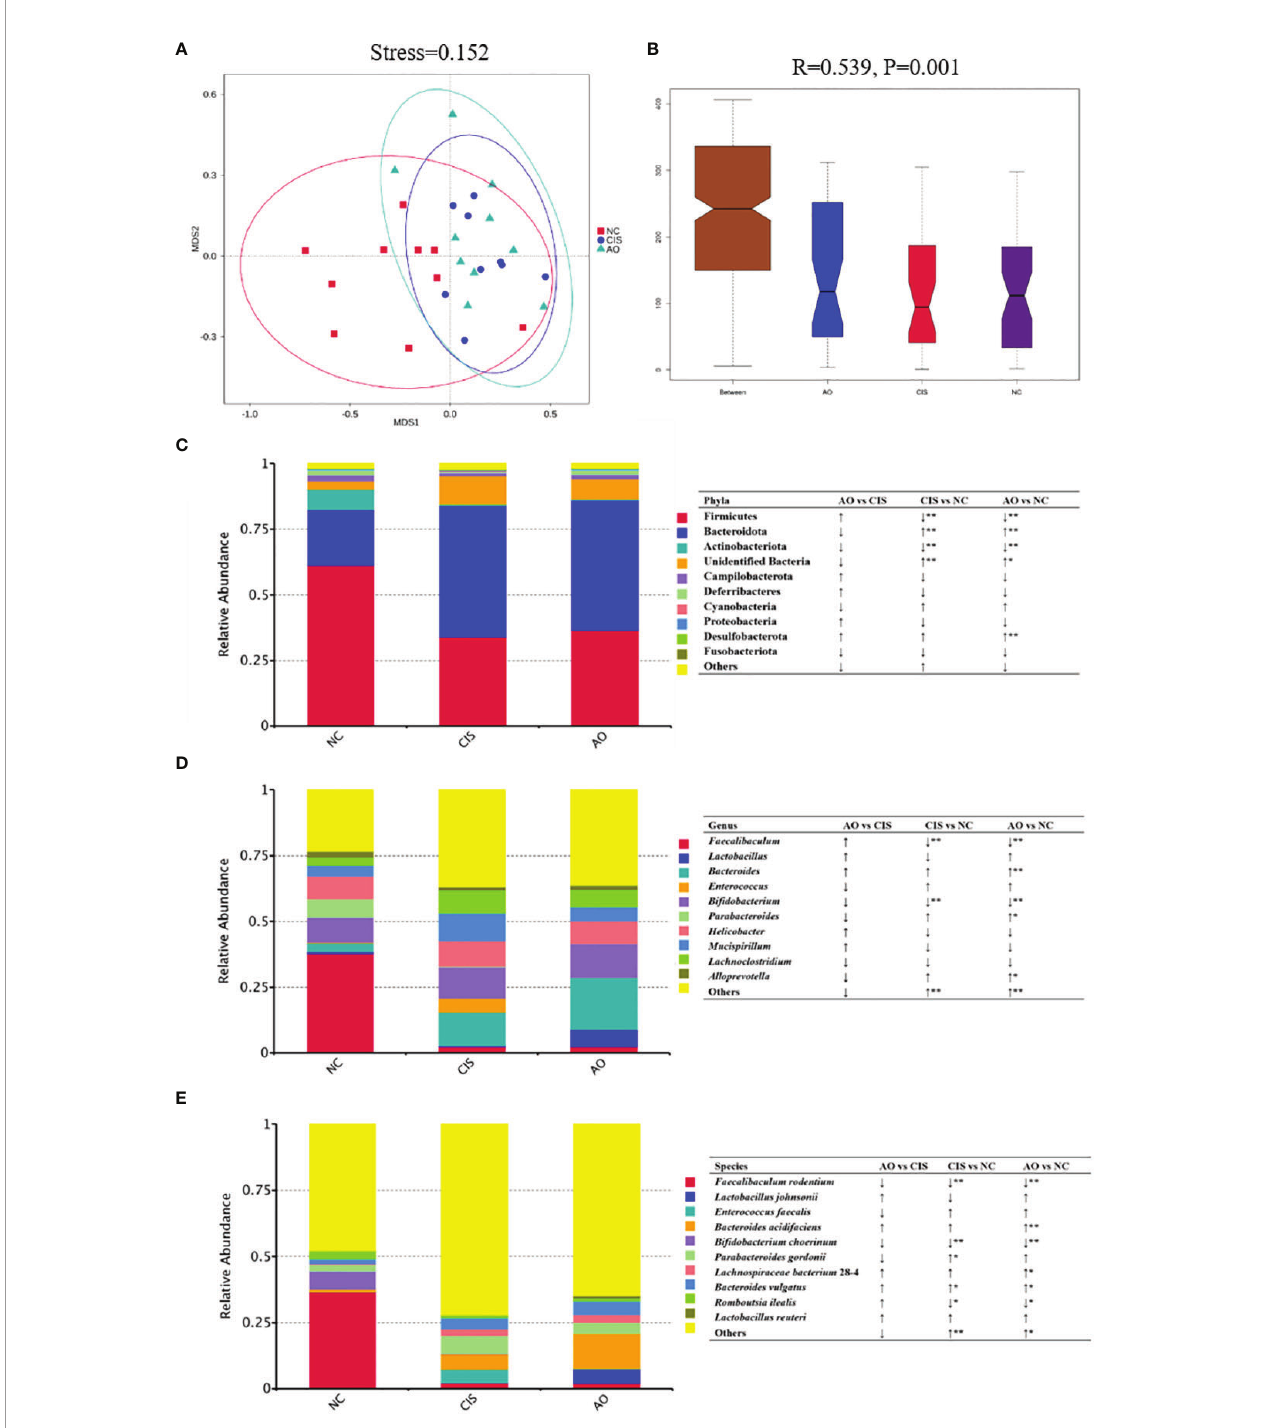
FIGURE 2 | Gut microbiota analysis. (A) Non-metric dimensional scaling (NMDS) plots; (B) ANOSIM analysis of the signi fi cance of separation between the NC, CIS, and AO groups; (C) relative abundance of the top 10 phyla; (D) relative abundance of top ten genus; (E) relative abundance of top ten species; n=10 for the AO and NC groups, n=9 for the CIS group (one mouse in the CIS group died while collecting feces). NC, normal control; CIS, cisplatin; AO, cisplatin with alginate oligosaccharides (* p < 0.05, ** p < 0.01; ↑ , upregulation; ↓ ,